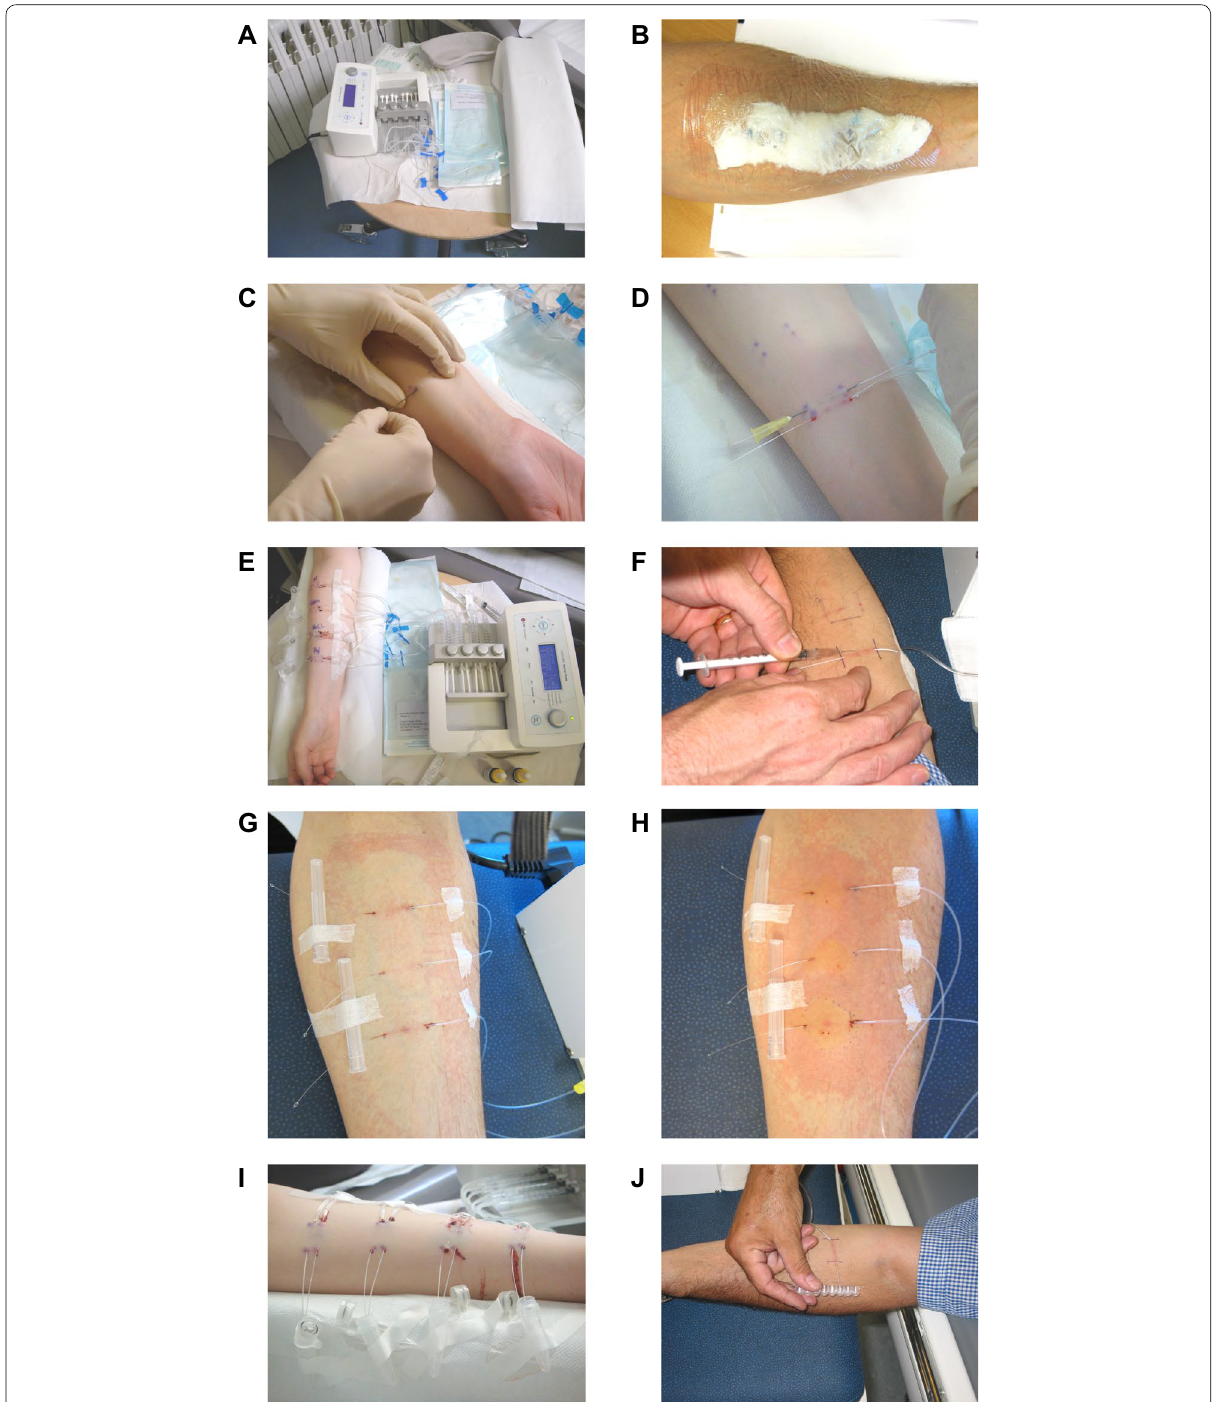
Fig. 2 An example of the SMD procedure. a Priming of microdialysis probes prior to insertion, b topical application of local anesthesia, c intradermal insertion of guide cannulas, d introduction of probes through the guide cannulas, e SMD setting and basal sampling, f skin challenge, g skin site before challenge, h wheal and flare reaction in response to intradermal challenge, i collection of dialysates—here in microtubes, j alternative collection of dialysates—here directly into sampling wells. Please refer to the SOPs (in vivo SMD SOP and ex vivo SMD SOP, provided as Additional files 1 and 2, respectively) for a detailed description of the SMD procedure. Pictures are reproduced with kind permission from Line Kring Tannert and Marcus